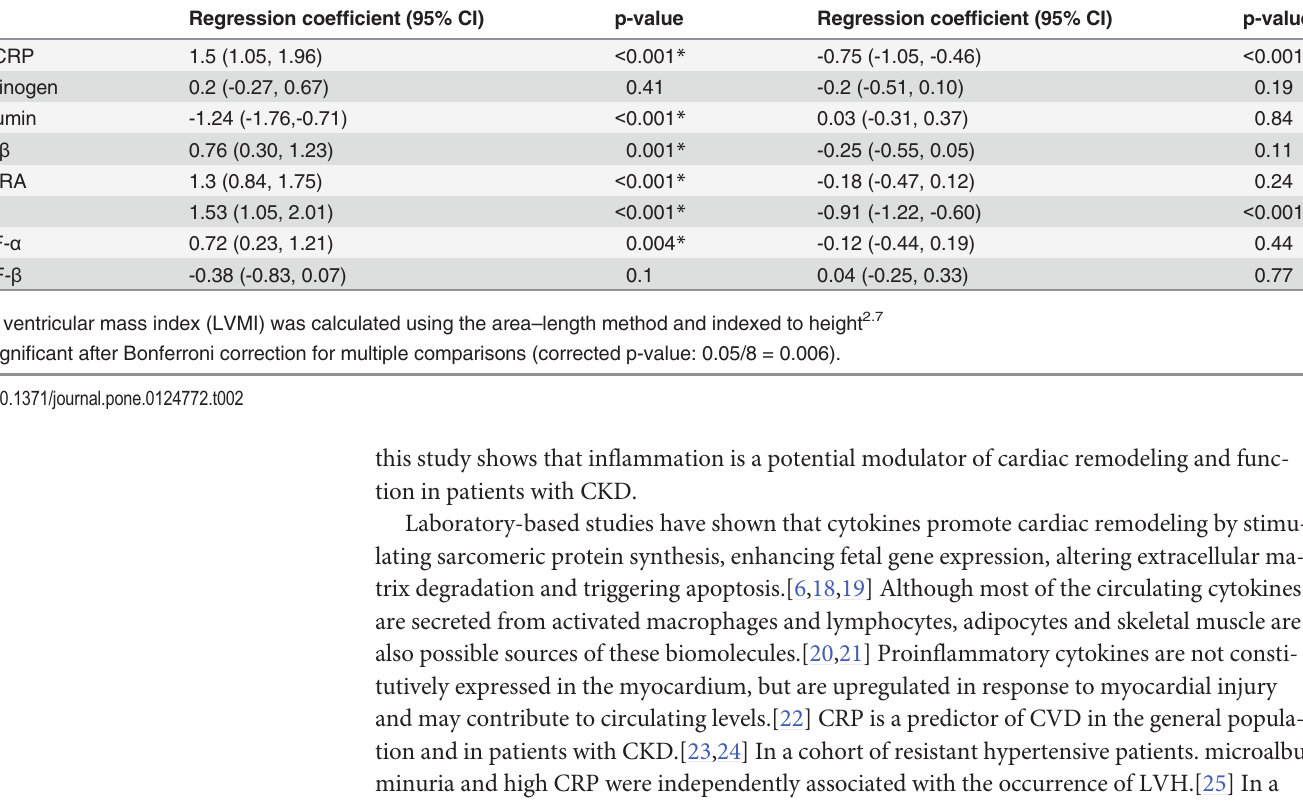
Table 3. Adjusted logistic regression models showing the association of inflammatory biomarkers with LVH, systolic dysfunction and diastolic dysfunction. Predictor Outcome Left ventricular hypertrophy; Systolic dysfunction; n = 3,484 Diastolic dysfunction; n = 3,053 n = 3,119 Odds ratio (95% CI) p-value Odds ratio (95% CI) p-value Odds ratio (95% CI) p-value hs-CRP 1.26 (1.16, 1.37) < 0.001 * 1.32 (1.18, 1.48) < 0.001 * 1.14 (1.04, 1.26) 0.005 * Fibrinogen 1.07 (0.98, 1.17) 0.14 1.02 (0.91, 1.15) 0.76 0.01 Albumin 0.88 (0.80, 0.97) 0.009 0.94 IL-1 β 1.11 (1.03 1.21) 0.01 1.04 (0.93, 1.17) 0.47 1.04 (0.95, 1.15) 0.39 IL-1RA 1.23 (1.13, 1.34) 1.04 (0.94 1.16) 0.45 0.05 IL-6 1.25 (1.14, 1.36) TGF-